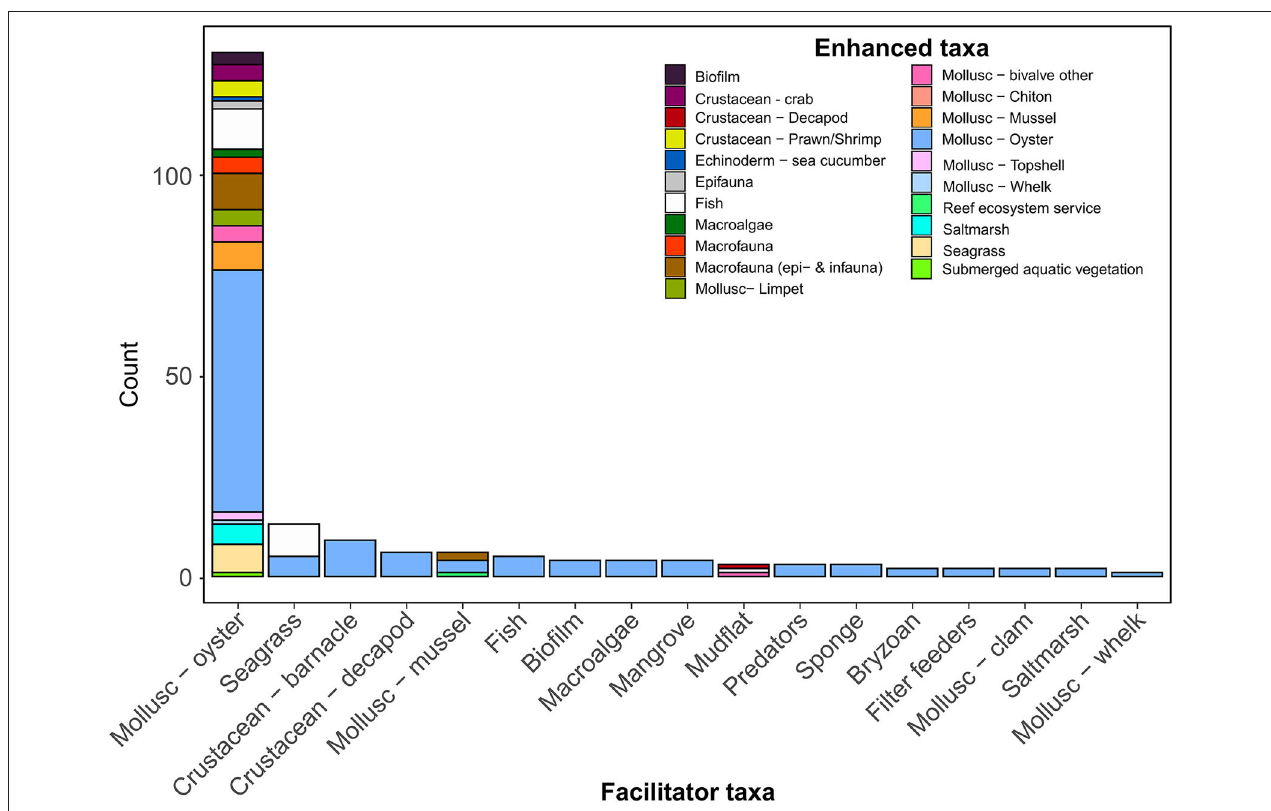
FIGURE 5 | Positive species interactions on oyster reef ecosystems. Taxa on the x-axis facilitate and enhance other taxa identified by the colored fill of the stacked bars (Enhanced taxa), with the number of observations for each facilitator-enhanced taxa pairing (species interaction) on the y-axis. For example, the Mollusc-whelk and Mollusc-Oyster pairing (far right bar) shows one observation where this interaction was